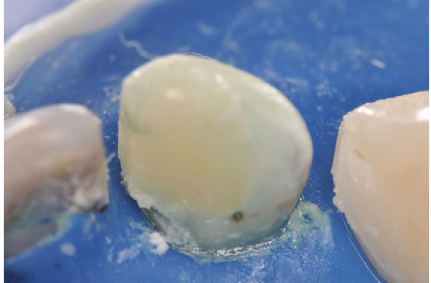
Figure 13: Temporary restoration with high viscosity glass ionomer cement Maxxion R (FGM Produtos Odontol´ogicos, Joinville, SC, Brazil).